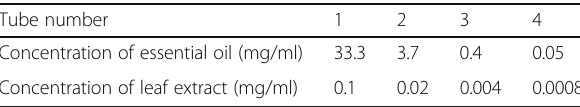
Table 1 Concentrations of plant extracts after dilution Tube number 1 2 4 Concentration of essential oil (mg/ml) Concentration of leaf extract (mg/ml)